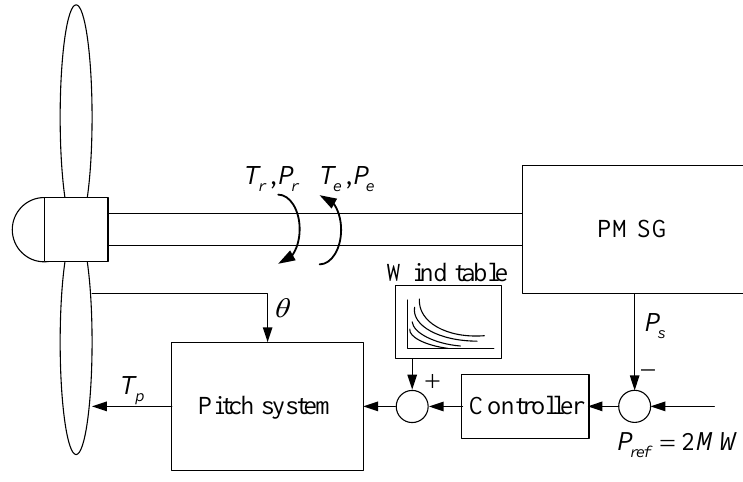
Figure 12. Control system configuration in Region 3.